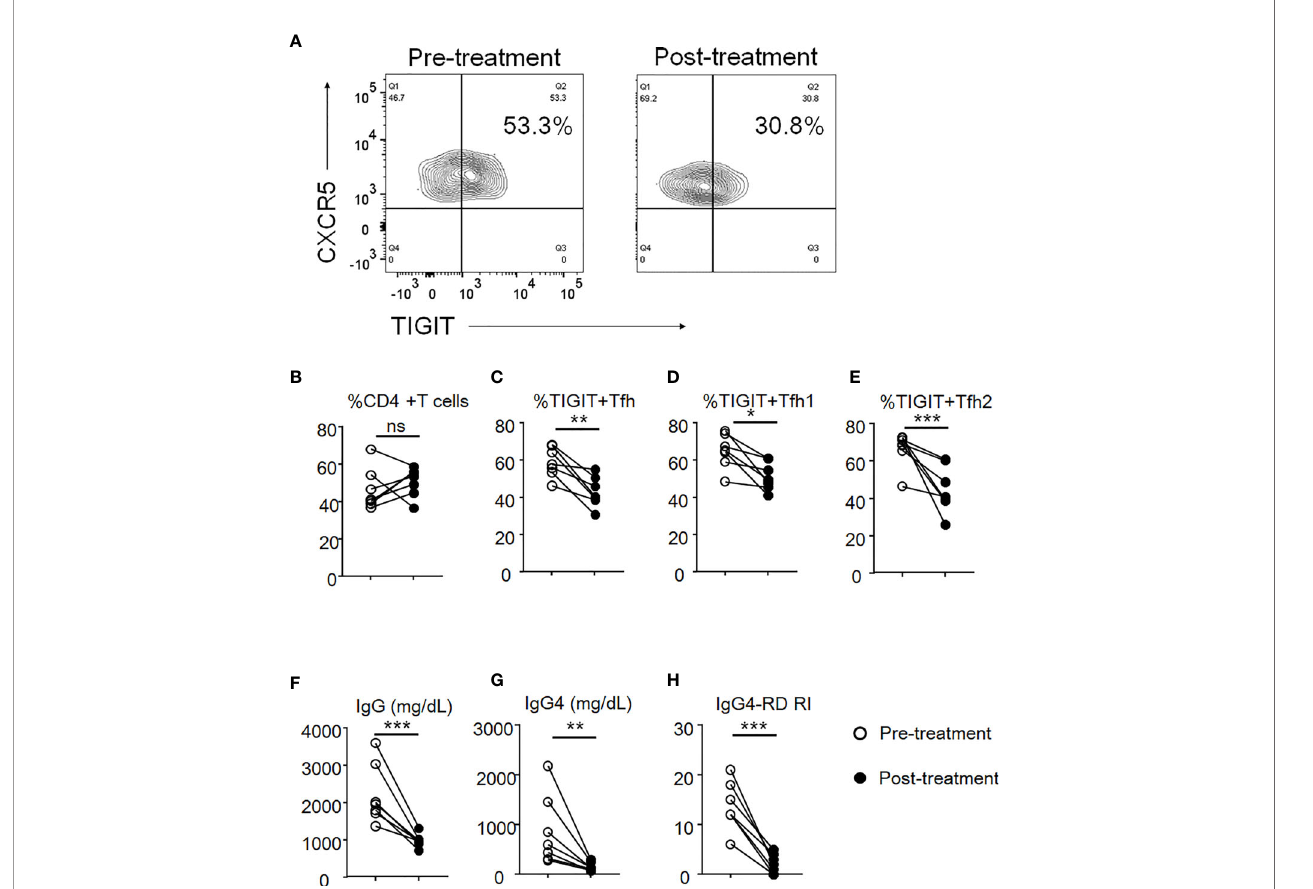
FIGURE 9 | The decrease of proportion of TIGIT + Tfh cells after glucocorticoid treatment. The proportion of total CD4 + T cells (B) , TIGIT+ Tfh (A, C) , TIGIT+ Tfh1 (D) , and TIGIT+ Tfh2 (E) were examined after 12 weeks of glucocorticoid treatment. Serum levels of IgG (F) and IgG4 (G) as well as the scores of IgG4-RD RI (H) were also analyzed. n=7. (B, E) and (F, G) repeated measures ANOVA. (H) paired t-test. ***p<0.001, **p<0.01, *p<0.05, ns